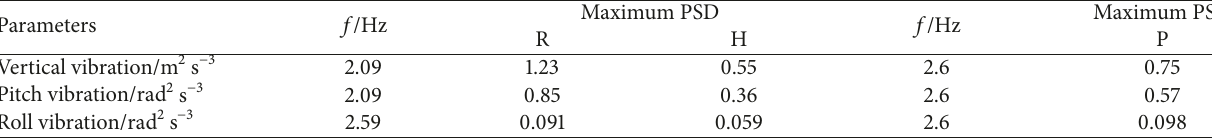
Table 5: The maximum PSDs of the acceleration responses with three cab’s isolation mounts.